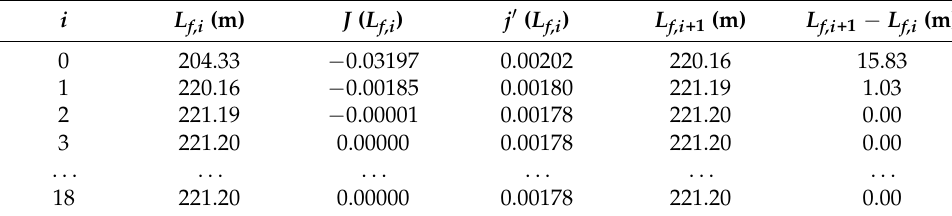
Table 1. Newton–Raphson method.